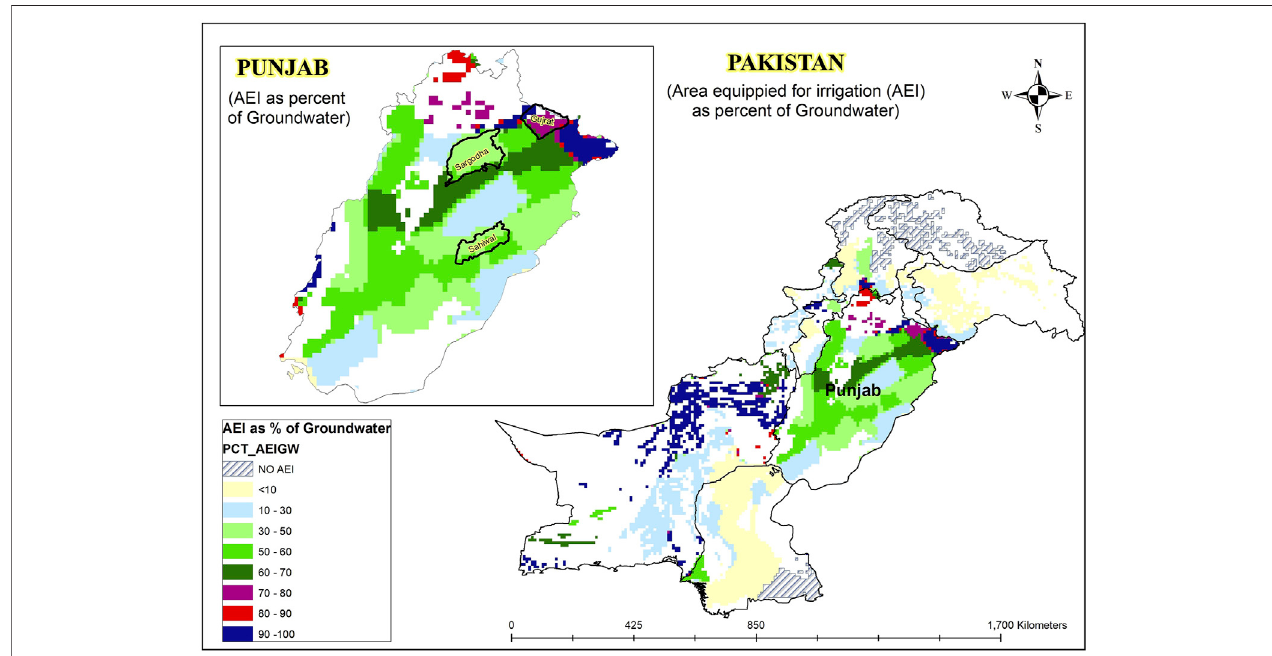
FIGURE 1 | Map of the study